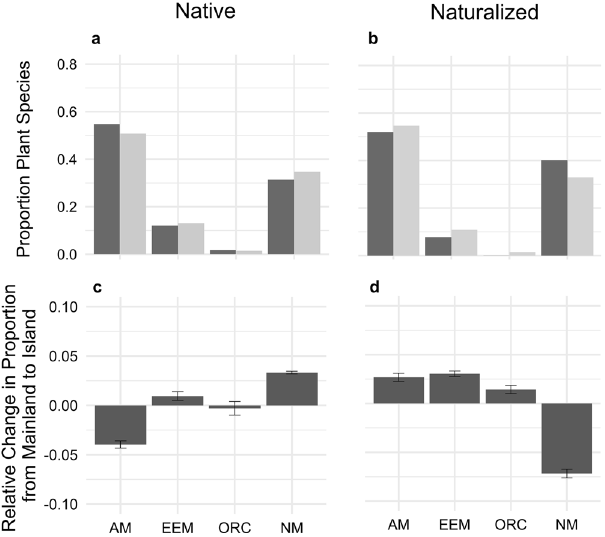
Fig. 2 Proportion of plant species of each mycorrhizal type in native and naturalized fl ora. Arbuscular mycorrhizal (AM) plant species represent a lower proportion of species in the native fl oras on oceanic islands (light gray) than on mainlands (dark gray), while all mycorrhizal types represent a higher proportion of species on islands than mainlands in the naturalized fl ora. Proportion of plant species within each mycorrhizal type: arbuscular mycorrhizal (AM), ecto- and ericoid mycorrhizal (EEM), orchid mycorrhizal (ORC), and non-mycorrhizal (NM). Panels a and b show these proportions for native ( a ) and naturalized ( b ) plant species; c and d show the difference between oceanic island and mainland in each type for native ( c ) and naturalized ( d ) species. Error bars represent standard errors of the means.